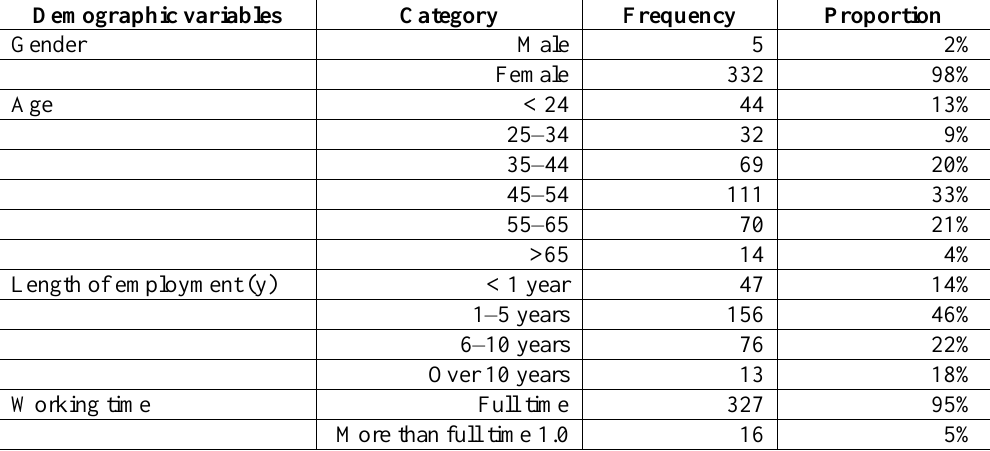
Table 1. Demographics/background information for study participants ( n = 340) Demographic